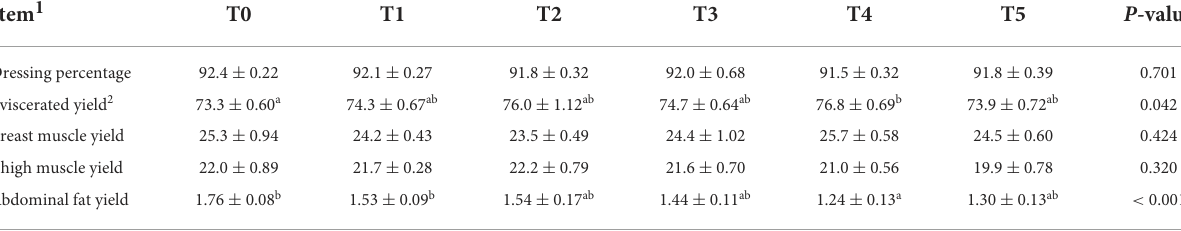
TABLE 3 Effects of adding CAP level (%) on slaughtered performances of 1–42d White-feather Broilers (means ± SEM).